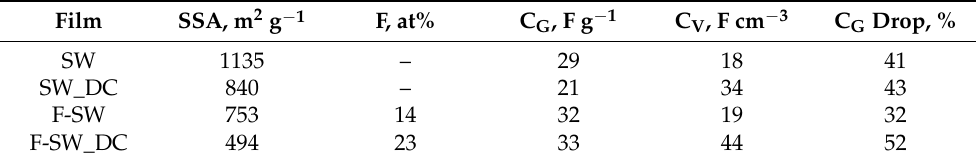
Table 1. Characteristics of studied films: specific surface area (SSA), fluorine content (F), gravimetric capacitance (C G ) and volumetric capacitance (C V ) obtained at 100 mV s − 1 , and drop in the gravimetric capacitance with an increase of the scan rate from 2 to 1000 mV s − 1